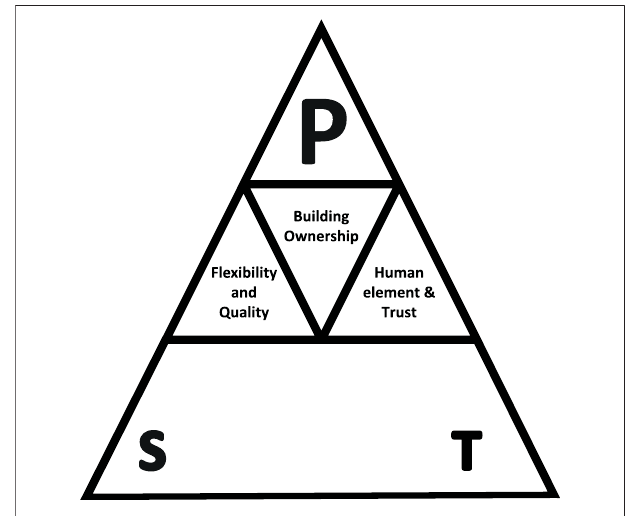
FIGURE 1 | Pedagogy, space and technology framework with